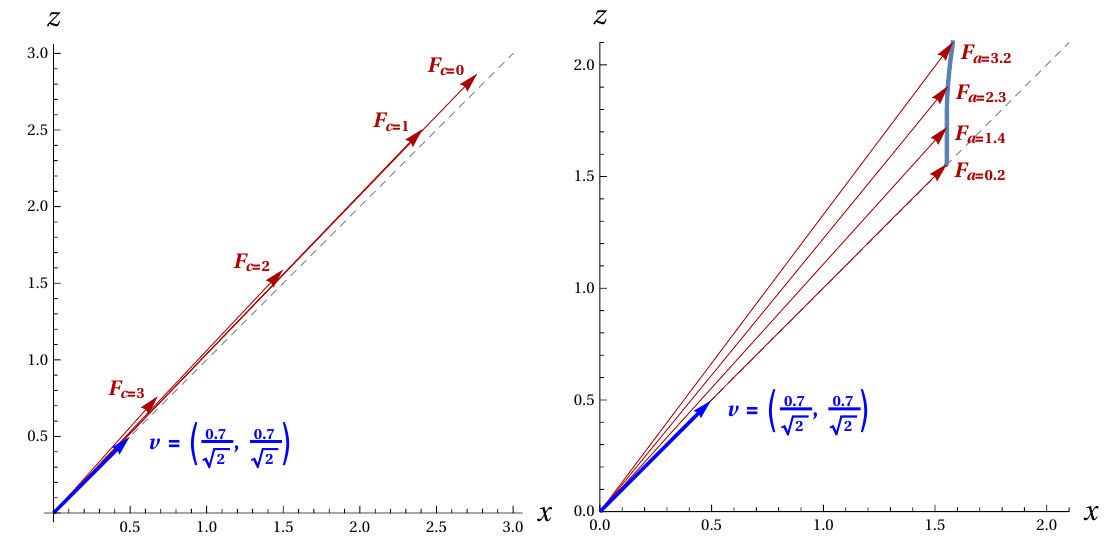
Figure 13 . It is shown how the force changes for di(cid:11)erent values of the two deformation parameters c and a for a velocity v = 0 : 7 at an angle (cid:18) = 45 (cid:14) . For the left plot, the anisotropy parameter was taken to be a = 1 : 4. The absolute value is decreasing whereas (cid:1) (cid:18) F is increasing for growing c . For the right plot, the non-conformal deformation was chosen to be c = 1. However, the results look alike for any c . Both the absolute value of the force and (cid:1) (cid:18) F increase for growing a . (cid:18) = 45 (cid:14) with the z -direction where the respective other parameter is chosen to be